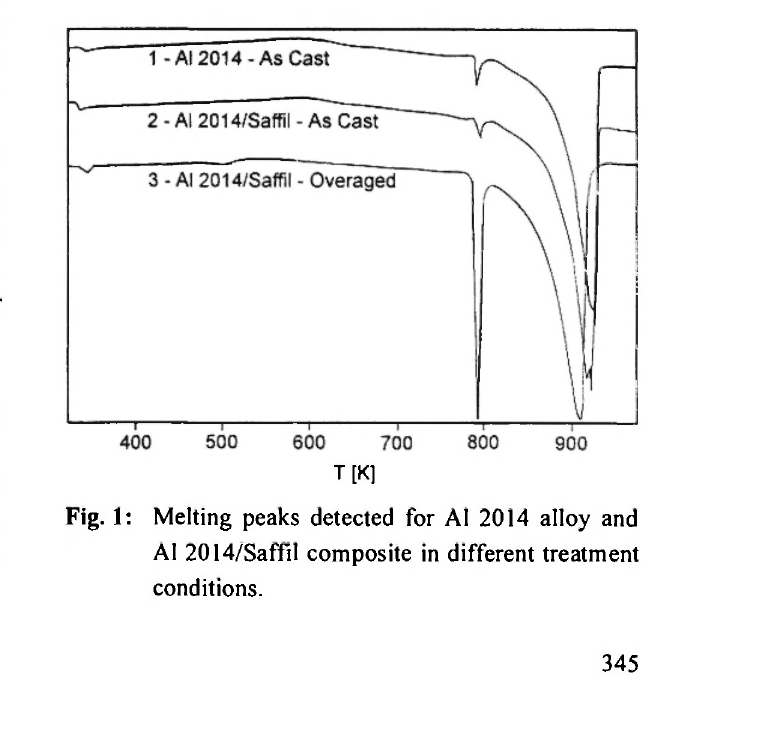
Fig. 1: Melting peaks detected for Al 2014 alloy and Al 2014/Saffil composite in different treatment